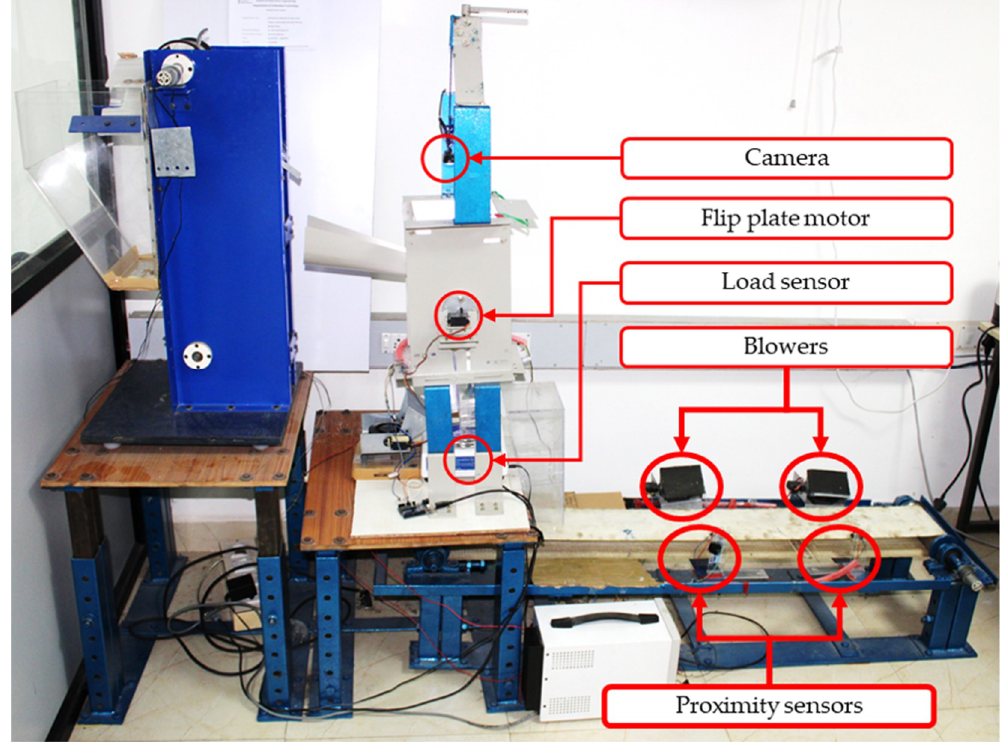
Figure 6. Developed prototype of silkworm cocoons multi-sensor classification system.